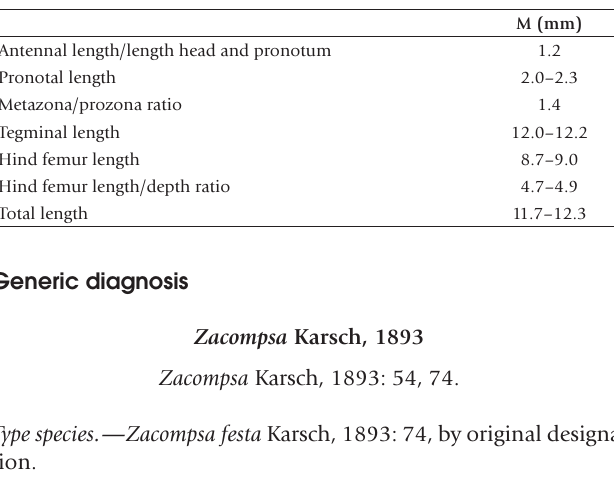
Table 11. Morphometric measurements of Tenuihippus